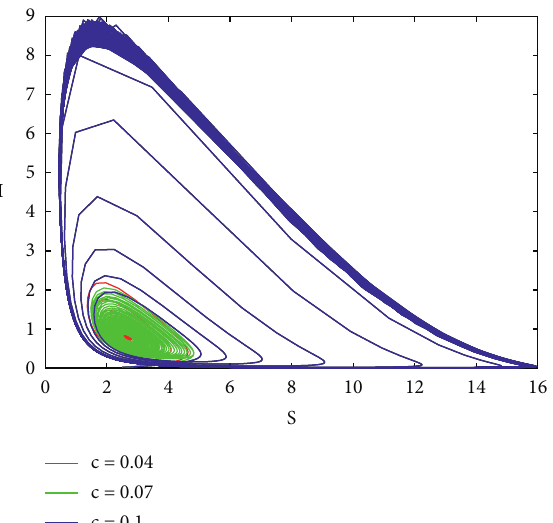
Figure 6: The trajectories and phase diagram of S , I -plane of model system (4). (a) Profile of S , I with respect to time when p � 0. (b) Phase trajectory for S , I -plane when p � 2.